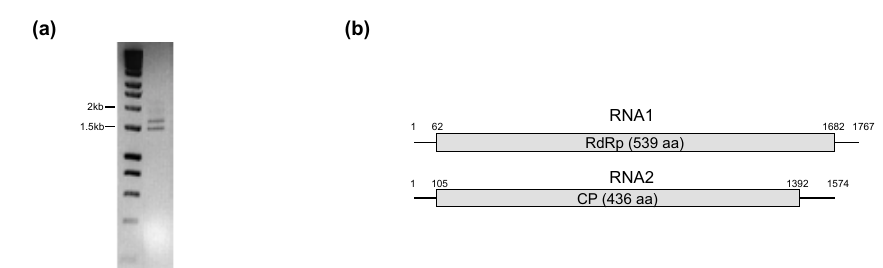
Figure 1. Characterization of Verticillium dahliae partitivirus 1 from olive (VdPV1-ol). (a) dsRNA banding pattern of V. dahl- iae D pathotype isolate Vd-253 from Turkey, analyzed by agarose gel electrophoresis. Size standard is shown on the left. (b) Schematic representation of the genomic organization of VdPV1-ol. The RdRp ORF (nt positions 62-1682 on RNA1) and the CP ORF (nt positions 105-1416 on RNA2) are represented by rectangular boxes.